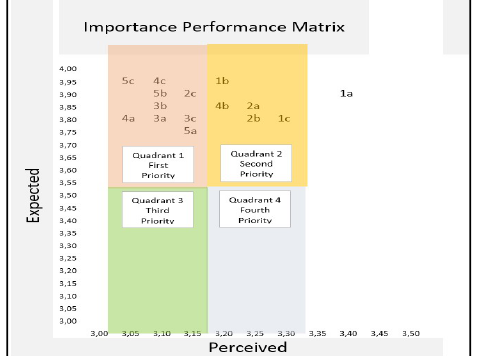
Fig. 3. Importance Performance Analysis Matrix